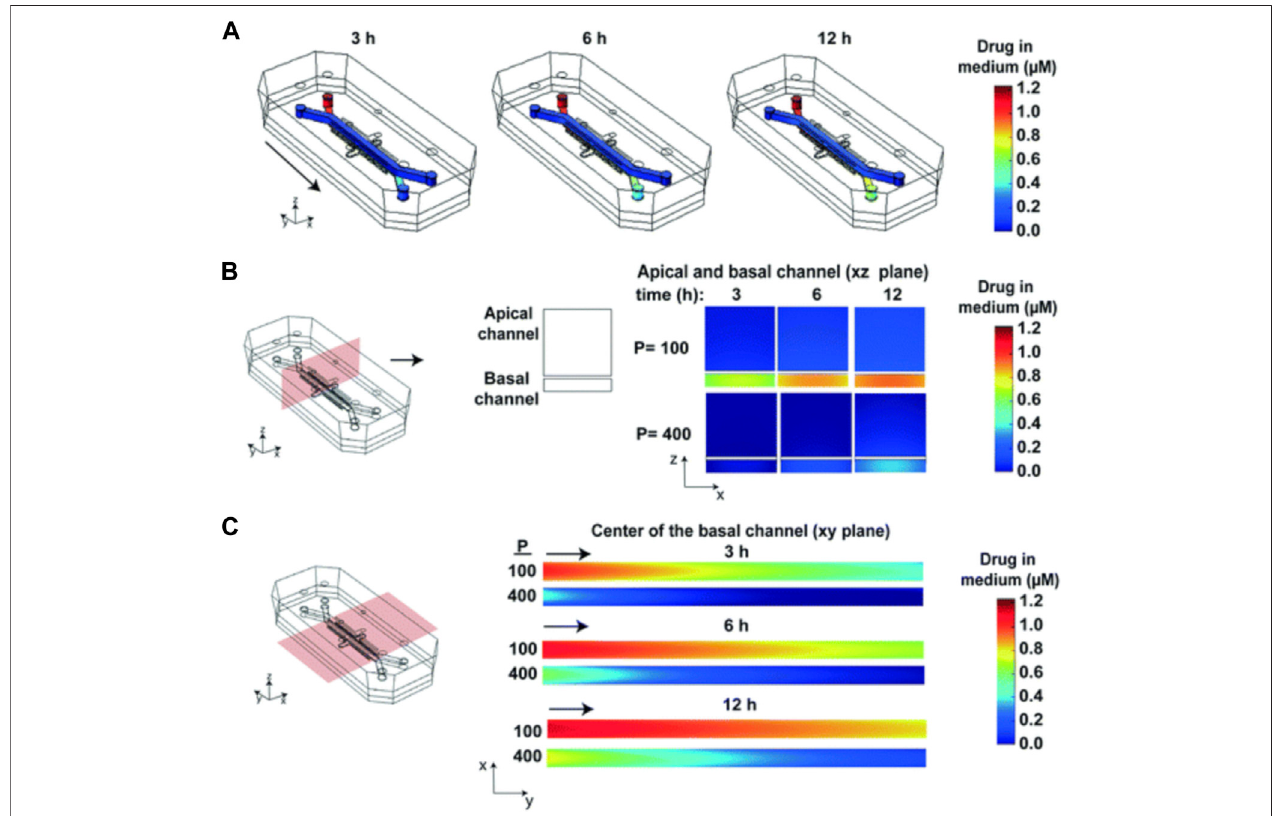
FIGURE10| Heatmapsofthedrugconcentration. (A) 3Dsurfaceheatmapsoftheconcentrationofdruginthe fl uidicchannelsofthehumanlungairwaychipat3, 6, and 12 h; (B) 2D heat maps of drug concentration through a vertical cross section in the center of the chip; (C) 2D heat maps of drug concentration through a horizontal cross section in the center of the basal channel (Grant et al.,